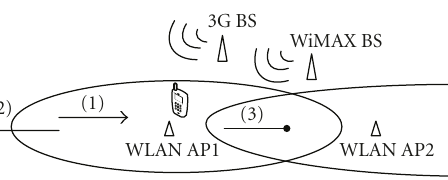
Figure 3: Example of proposed